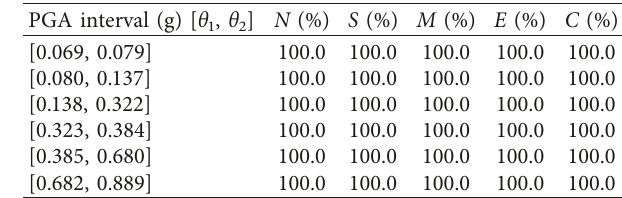
Table 8: Plausibility measure of damage subsets in equation (16) using equation (4) based on the degree of belief m in Table